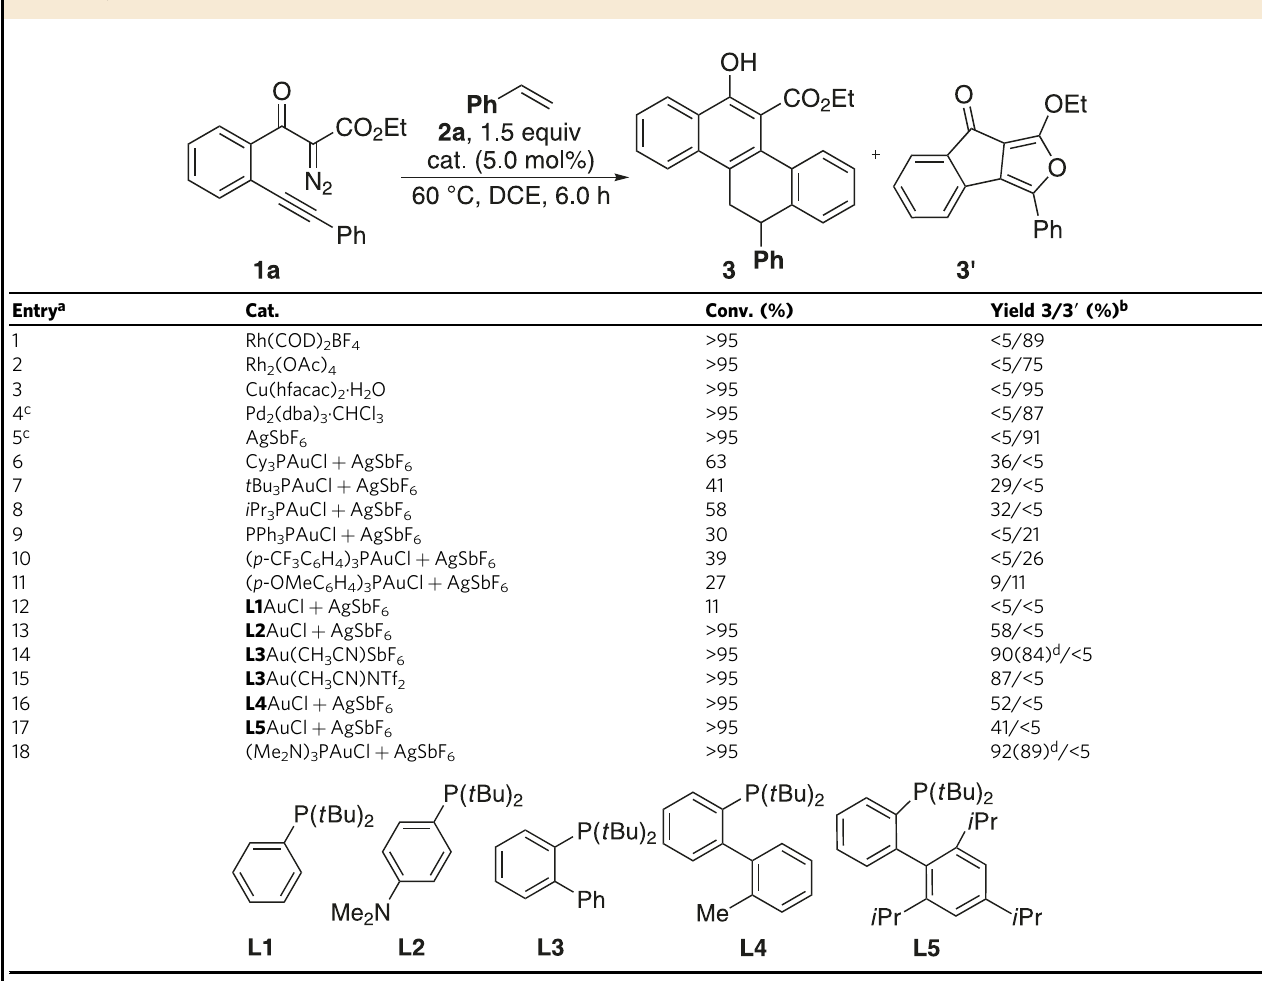
Table 1 Optimization of the